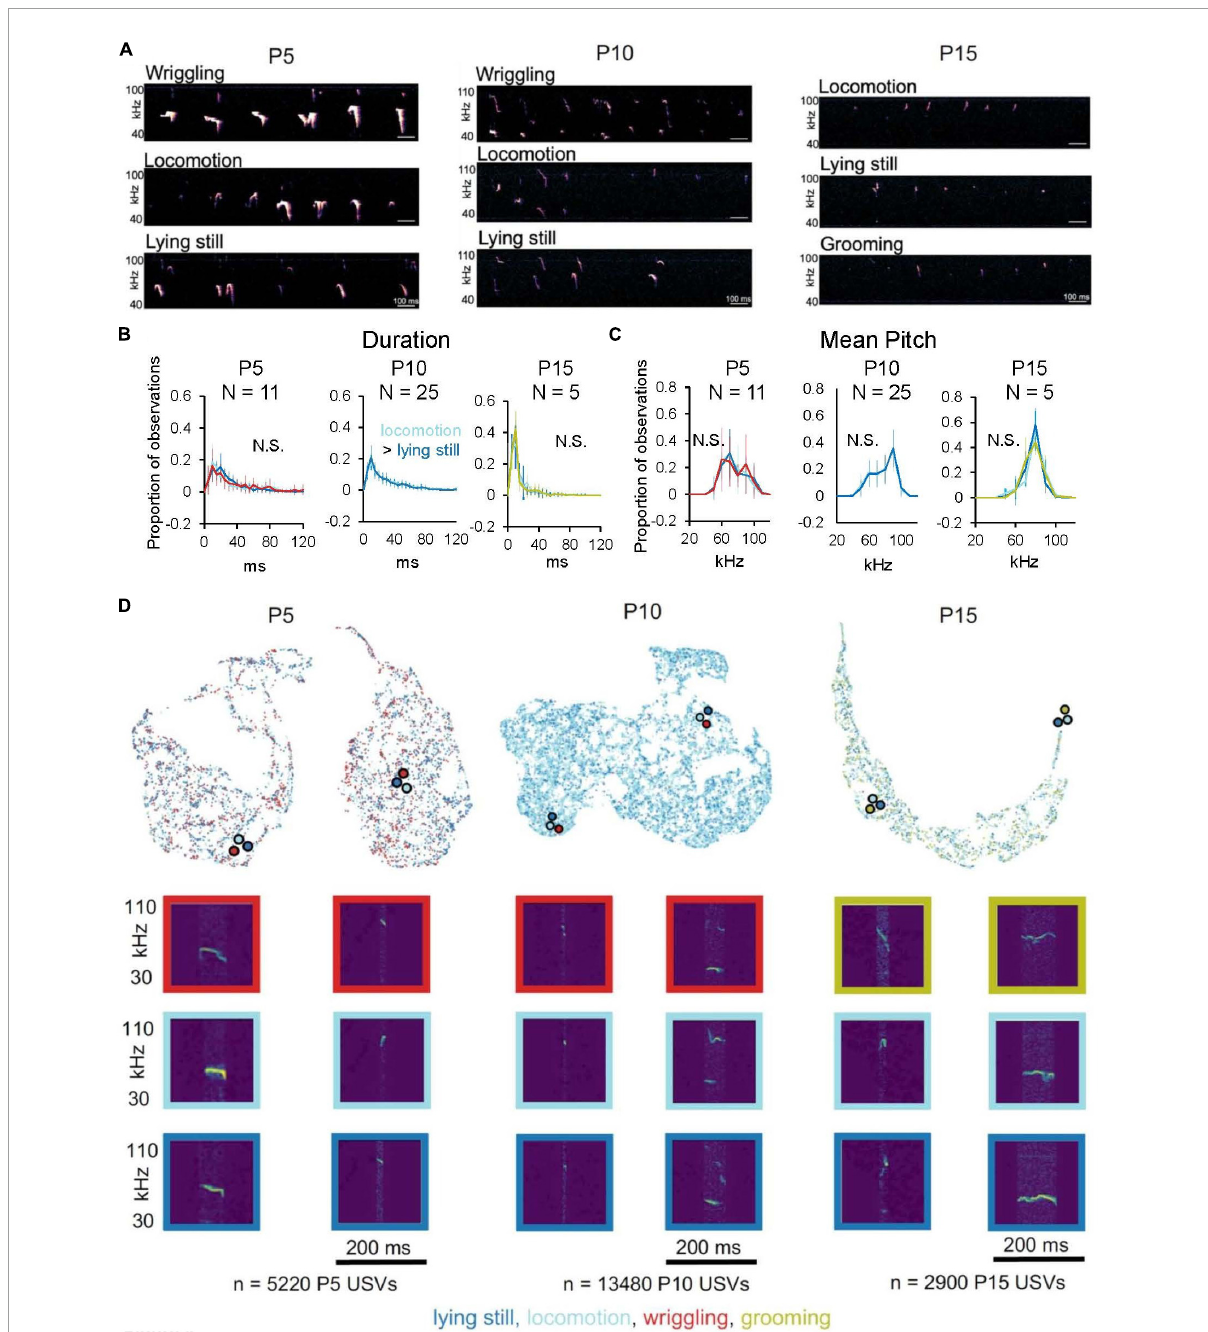
FIGURE4 Relationship of USV acoustic features to non-vocal behaviors. (A) Spectrograms of representative isolation USVs produced by P5 (left), P10 (middle), and P15 mice (right) during different non-vocal behaviors. (B) The mean distributions of durations of isolation USVs produced during different non-vocal behaviors are shown for P5 (left, N = 11), P10 (middle, N = 25), and P15 mice (right, N = 5). P10 mice produced < 50 total USVs during wriggling, so P10 wriggling USVs are excluded from analysis. (C) The mean distributions of mean pitch of isolation USVs produced during different non-vocal behaviors are shown for P5 (left, N = 11), P10 (middle, N = 25), and P15 mice (right, N = 5). Significant differences in median values of USV acoustic features between different non-vocal behaviors are indicated by text in each panel; p < 0.05 for indicated comparisons. (D) UMAP projections of latent descriptions of USV syllables produced by P5 (left), P10 (middle), and P15 mice (right). Representations of individual syllables are outlined in color according to the non-vocal behavior that occurred while that syllable was produced: lying still (dark blue), locomotion (light blue), wriggling (red), and grooming (chartreuse). Example spectrograms are depicted below, and color-coded dots with black outlines indicate landmarks on the Bokeh plot for the representative spectrograms. Number of USVs at P5 produced during wriggling: 1,409, lying still: 2,017, locomotion: 1,489; P10 USVs produced during wriggling: 41, locomotion: 10,410, lying still: 2,912; P15 USVs produced during locomotion: 1,915, lying still: 478, grooming: